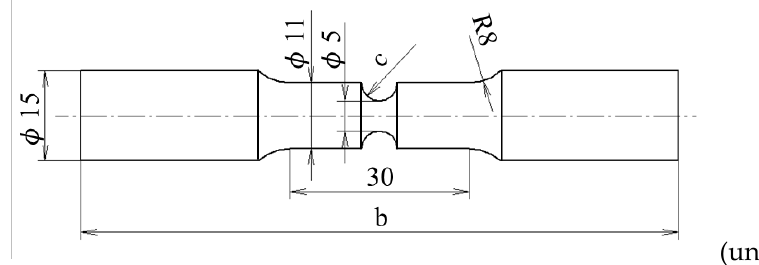
Figure 3. Notched round bar specimen for tensile test (b: 80, 90, or 100, c: R1 or R3).